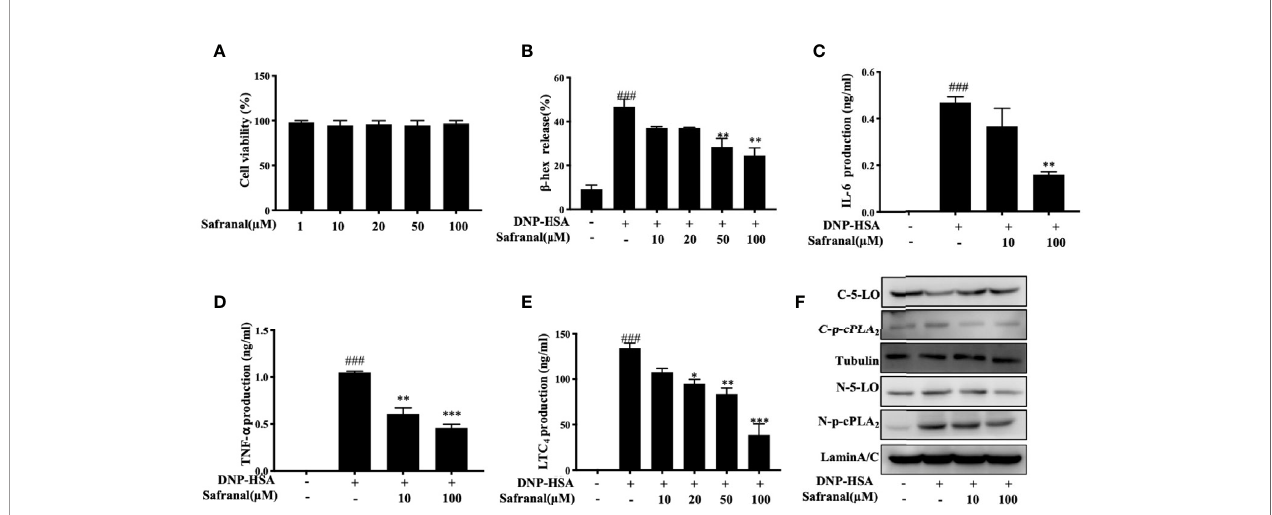
FIGURE 6 | Safranal inhibited degranulation and decreased in fl ammatory mediator production in BMMCs. (A) Cytotoxicity of safranal in BMMC. Cells were treated with various concentrations of safranal, cell viability was measured using the MTT assay. (B – E) BMMCs were incubated with safranal and stimulation with DNP-HSA. Supernatant were collected and analyzed for b -hexosaminidase, IL-6, TNF- a , and LTC 4 production. (F) Level of 5-LO and p-cPLA 2 in cytosol and nucleus were analyzed by western blot analysis. The data shown are representative of three independent experiments. Data are the means ± S.E.M. of three independent experiments. ### p <0.001 compared to nontreated group, * p <0.05, ** p <0.01, *** p <0.001 compared to